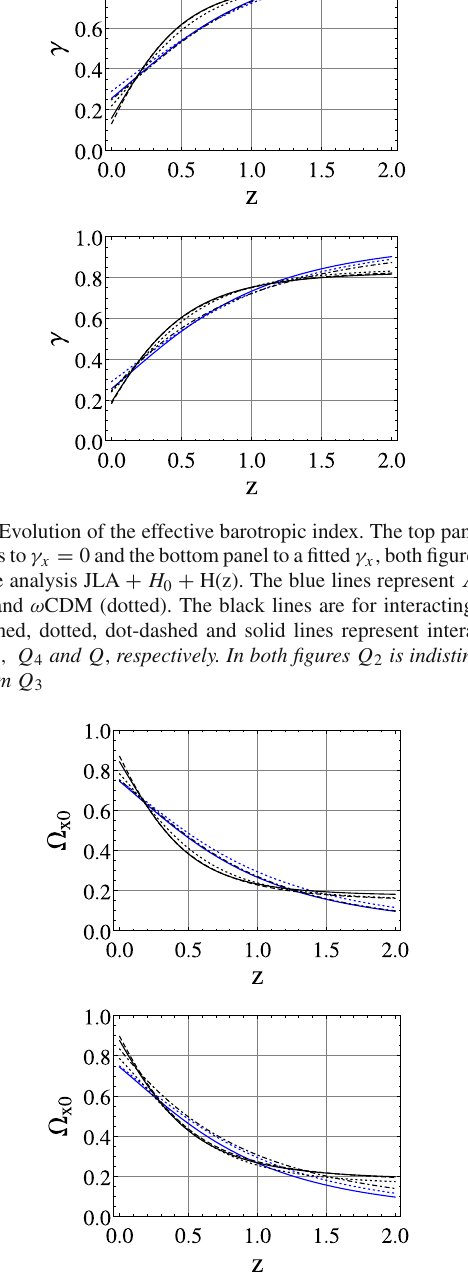
Fig. 3 Evolution of the density parameter for dark energy. The top panel corresponds to γ x = 0 and the bottom panel to a fitted γ x , both figures consider the analysis JLA + H 0 + H(z). The blue lines represent Λ CDM (solid) and ω CDM (dotted). The black lines are for interacting models,dashed,dotted,dot-dashedandsolidlinesrepresentinteractions Q 1 , Q 3 , Q 4 and Q , respectively.Inbothfigures Q 2 isindistinguishable from Q 3